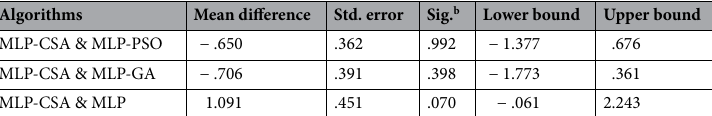
Algorithms Mean difference Std. error Sig. b Lower bound Upper bound